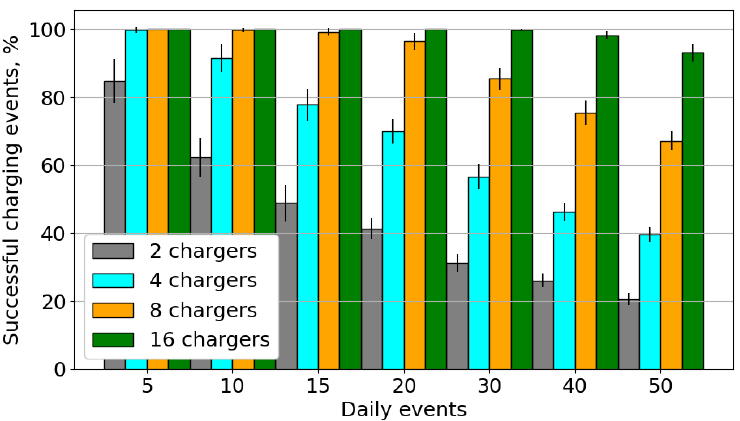
Figure 8. Mean values of successful charging events in percentages for four sets of chargers and various number of daily events. Vertical black bars illustrate the 95% confidence interval of the mean value.